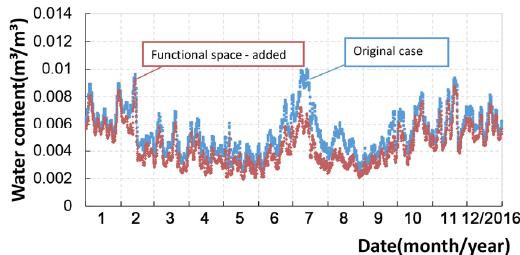
Figure 17. Point 4—water content change.